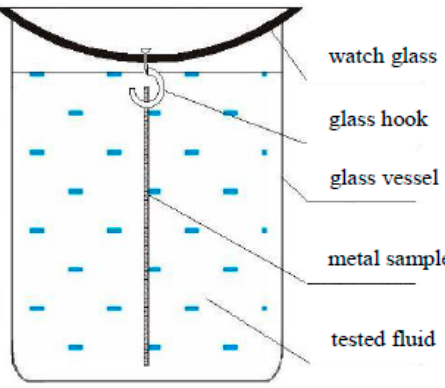
Figure 2. Set-up for testing the dispersing properties of paraffin inhibitors.